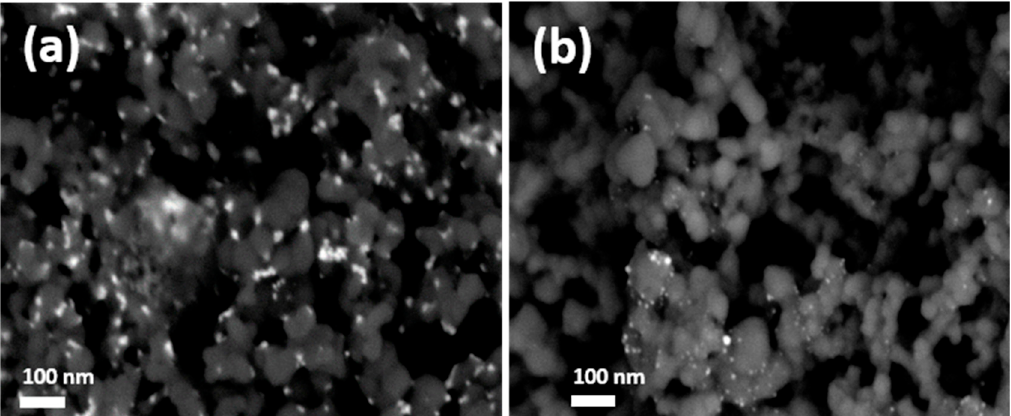
Figure 5. Back-scattered electrons field emission SEM images of the Bi-based electrodes with Bi loading of 0.1 mg cm − 2 : ( a ) as-prepared, and ( b ) after aprox. 70 h in 3-h CO 2 reduction experiments at different potentials.